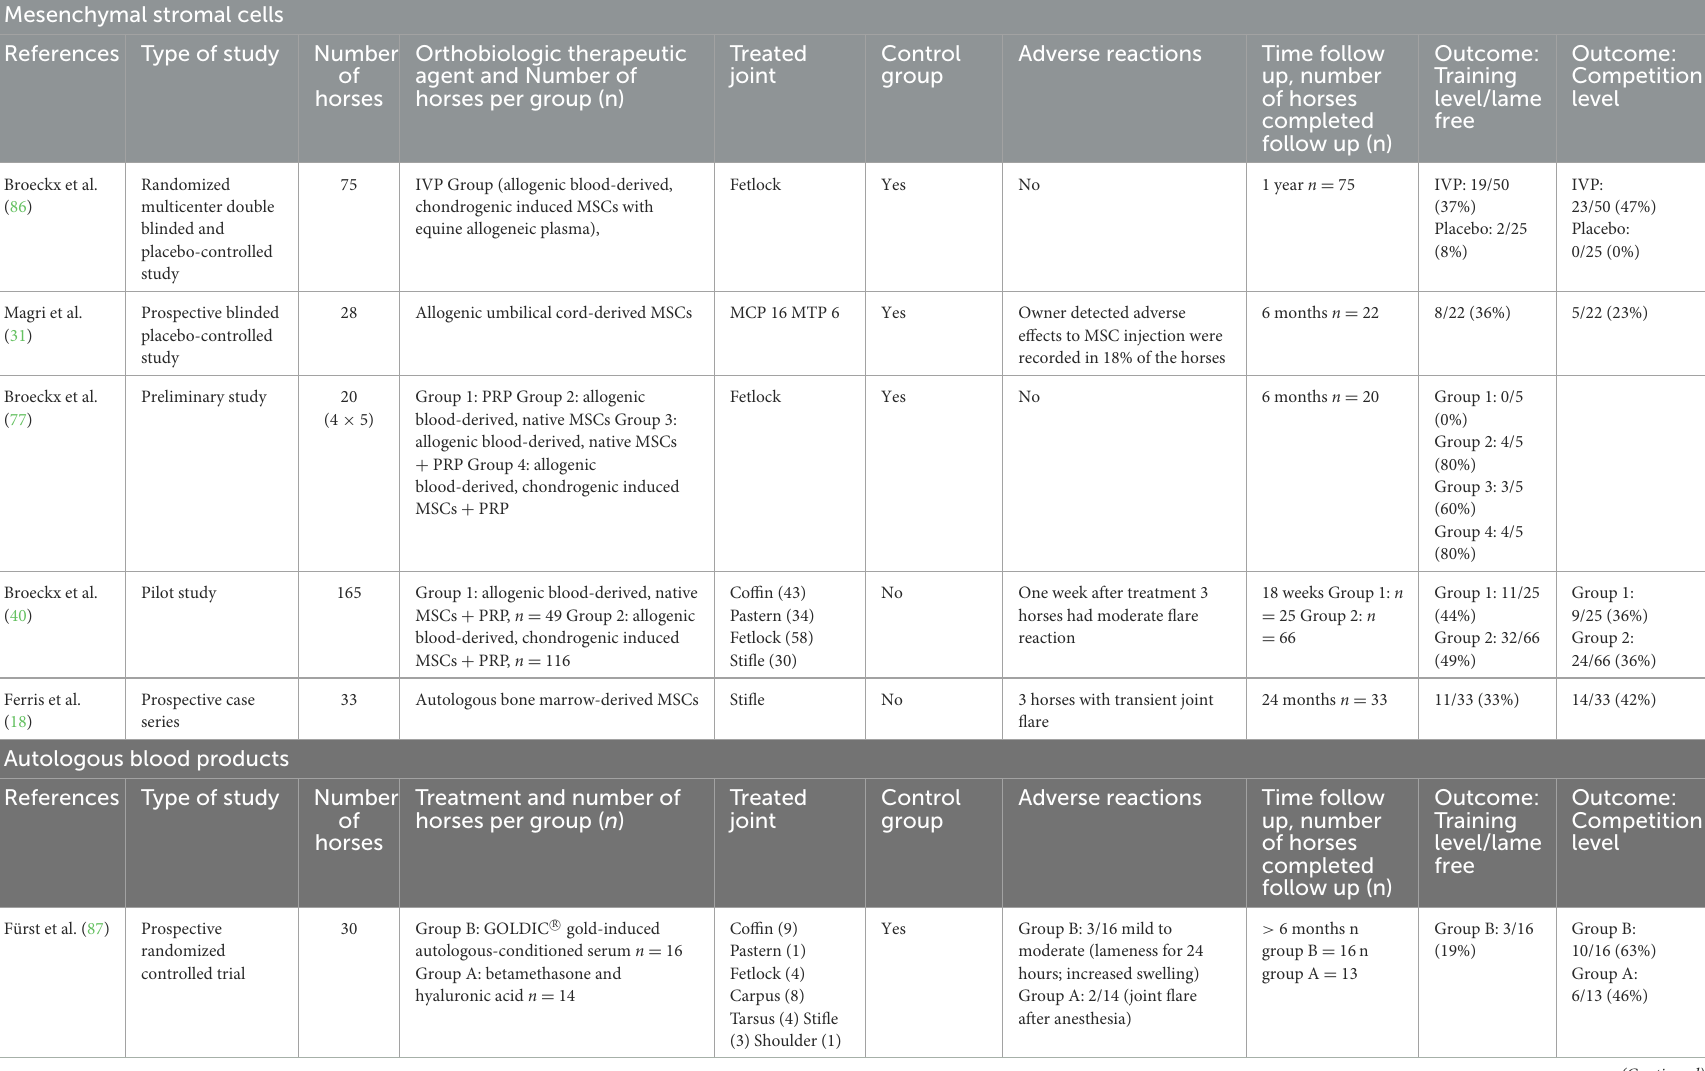
TABLE 1 Summary of all studies on naturally occurring OA included in the systematic